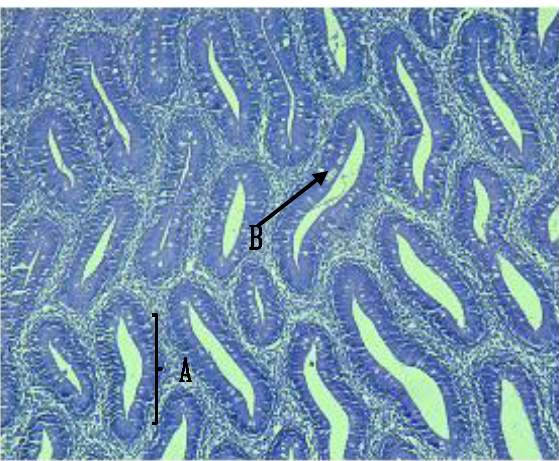
Figure, 10: Longitudinal microscopic section of middle portion of intestine of common carp, (A)mucosal fold, (B) goblet cells(arrow), AB stain (X 152